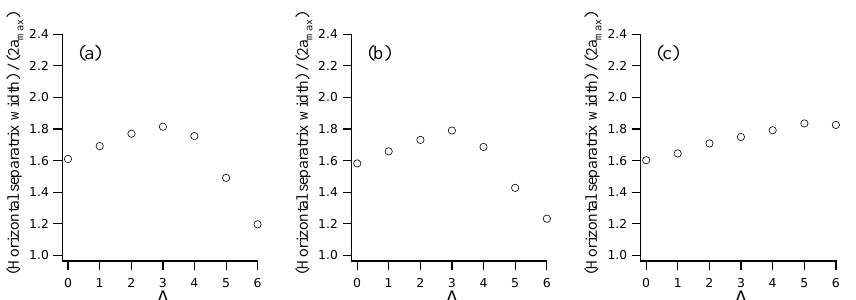
FIG. 6. The horizontal separatrix width of the 2:1 particle-core resonance in the cases with h x (cid:1) 0.9 . Three different combinations of M and j are considered, i.e., (a) M (cid:1) 0.13 and j (cid:1) 0.15 , (b) M (cid:1) 0.066 and j (cid:1) 0.15 , and (c) M (cid:1) 0.13 and j (cid:1) 0.075 .